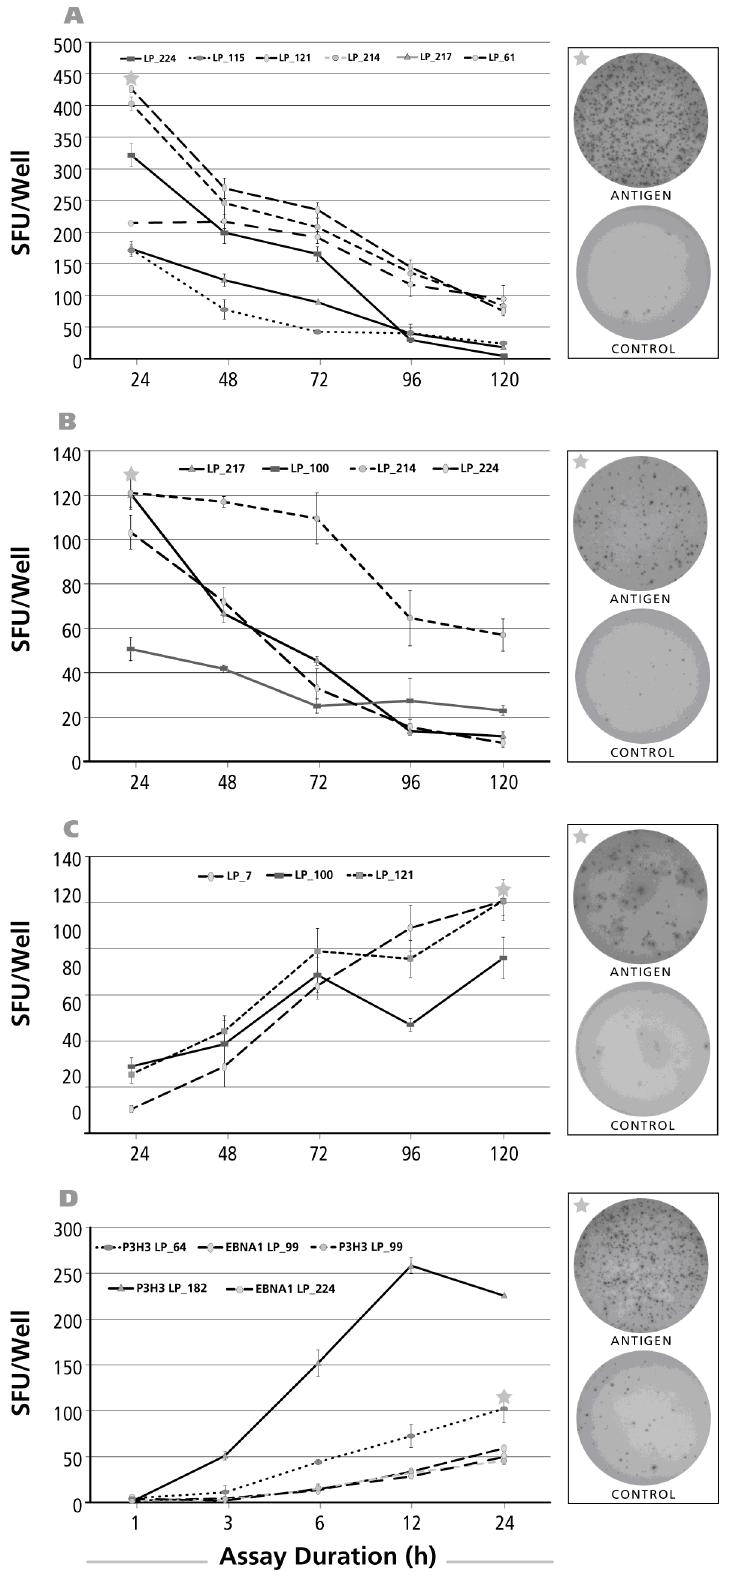
Figure 5. Kinetics of the IL-2 recall response by Th1 cells. The legend to Figure 2 applies, except that an IL-2 ELISPOT assay was done with donors and antigens that scored positive for IL-2. The antigens used to elicit IL-2 production were, in Panel ( A ); CMV gr.2; in Panel ( B ) PPD; and in Panel ( C ) dust mite; In Panel ( D ), the IL-2 assay duration was 1, 3, 6, 12 and 24 h with the insert specifying the donor/antigen combinations tested.